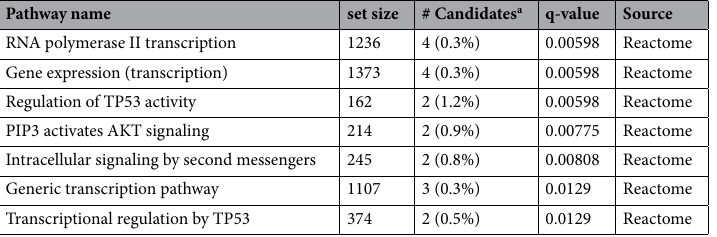
Supplemental Table S5 and Table 2 summarize the overall results (detail result in each molecular level) for the multi-omics analysis with p-values for novel genes identified through the multi-omics approach and for candidate genes selected from the publicly available literature. The transcription prediction model included the nine genes in the logistic regression model with the derived AUC from the testing set (baseline RNA microarray) at 0.83 (90% C.I. 0.62–1.00). For the protein prediction model, the AUC of the prediction model, using baseline protein levels as predictors, was poor (< 0.5). However, when